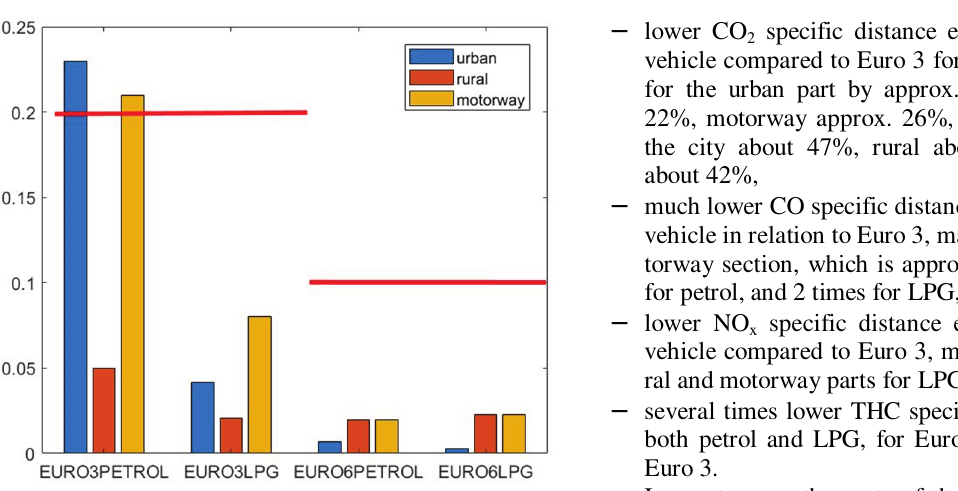
Fig, 18. Specific distance emission of THC for selected parts of road tests (red line is emission